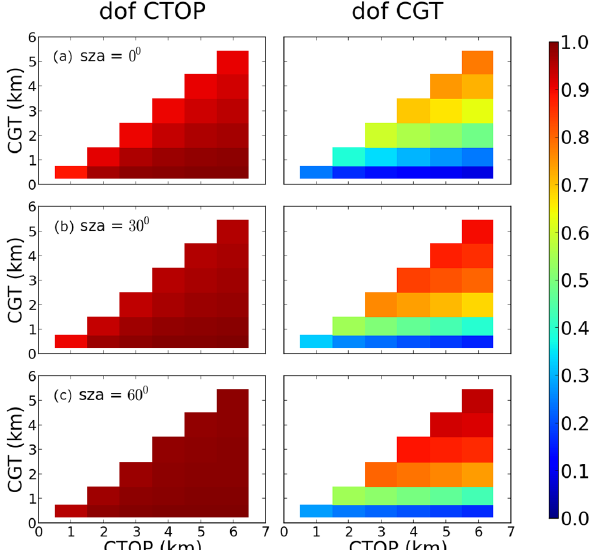
Figure 18. Information content of 3MI A-band with a COT of 16 for different illumination angles: (a) SZA = 0 ◦ , (b) SZA = 30 ◦ , (c) SZA = 60 ◦ . Partial DOFs for CTOP (left) and CGT (right).